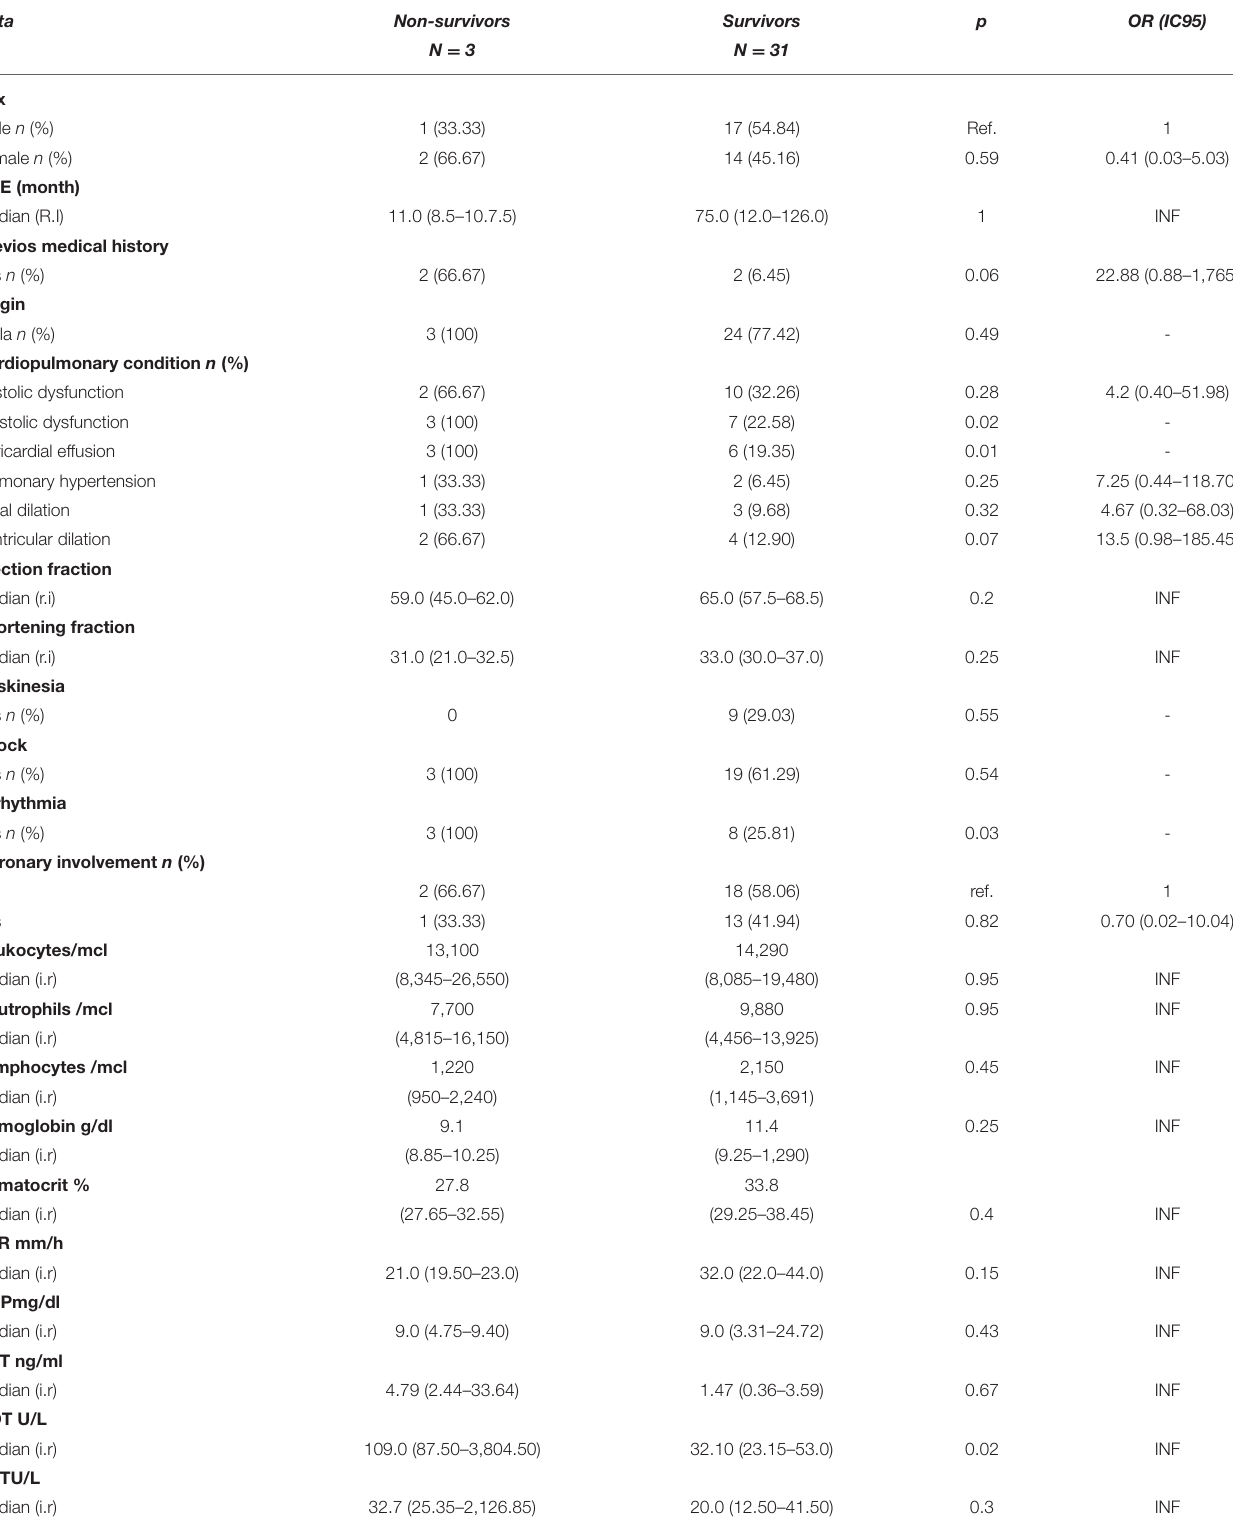
TABLE 3 | Risk analysis in survivors and non-survivor MISC